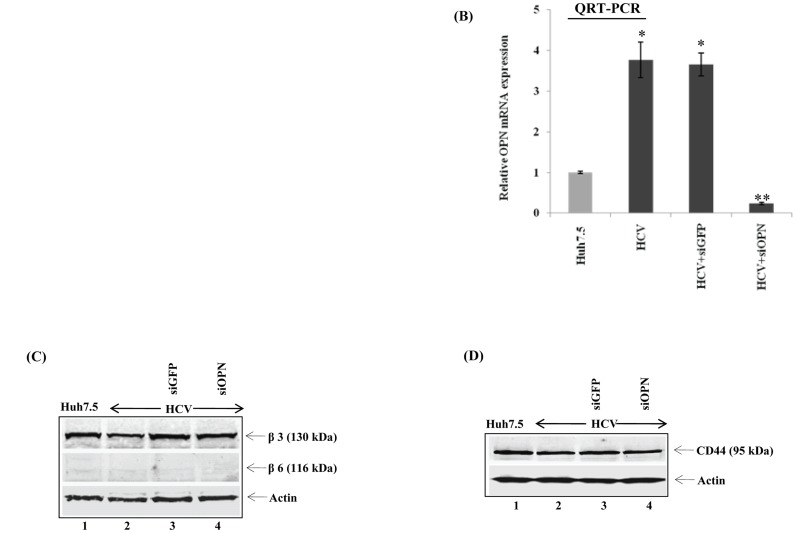

Effect of HCV-induced OPN on αVβ3 and CD44
                            expression.
(A) Huh7.5 cells were incubated with HCV (m.o.i. of 1). At day 3
                            postinfection, cells were immunostained using anti-NS5A antibody as
                            described in Materials and Methods. (B) Silencing of OPN mRNA
                            expression. The above HCV-infected cells (panel A) were transfected with
                            siGFP and siOPN using lipofectamine 2000 as per manufacturer’s
                            instruction (Invitrogen). At 72 h posttransfection, cellular RNA was
                            extracted and expression of OPN mRNA was quantified by QRT-PCR. OPN mRNA
                            expression was normalized by 18S rRNA. Data represent means+standard
                            deviations of two independent experiments performed in duplicate.
                            *denotes p<0.05 compared to mock-infected Huh7.5 cells.
                            **denotes p<0.05 compared to HCV-infected Huh7.5 cells
                            transfected with siGFP. (C, D) Cellular lysates from the above siRNA
                            transfected cells (panel B) were immunoblotted using anti-β3,
                            anti-β6 and anti-CD44 antibodies. Actin was used as protein
                            loading controls.